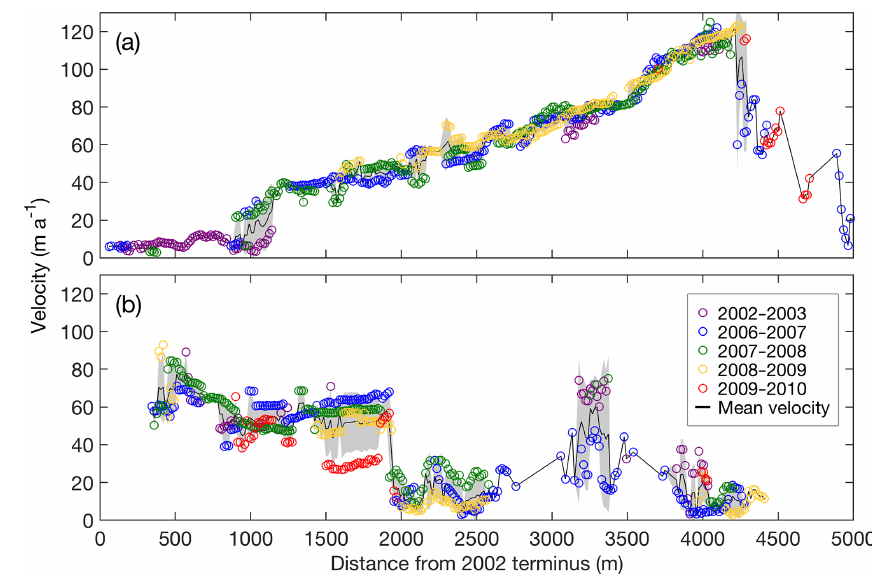
Figure 3. Surface flow velocities along the central flow lines of (a) Thorthormi and (b) Lugge glaciers for the 2002–2010 study period. The black lines are the mean flow velocities from 2002 to 2010, with the shaded grey regions denoting the standard deviation. The distance from each respective 2002 glacier terminus is indicated on the horizontal axis.